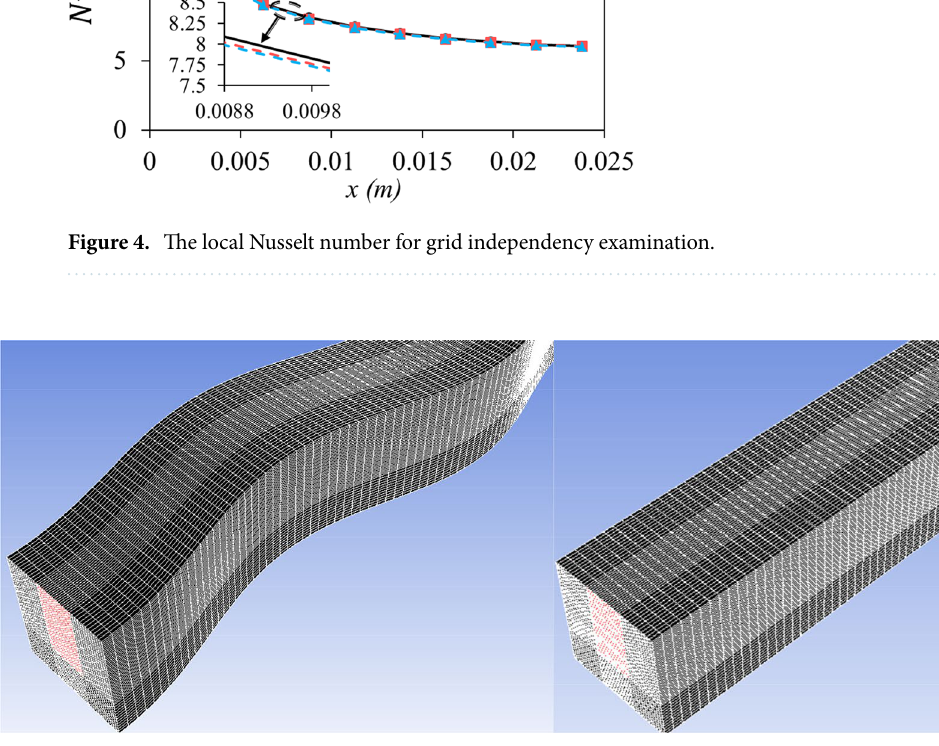
Figure 5. A view of generated mesh for both straight and wavy